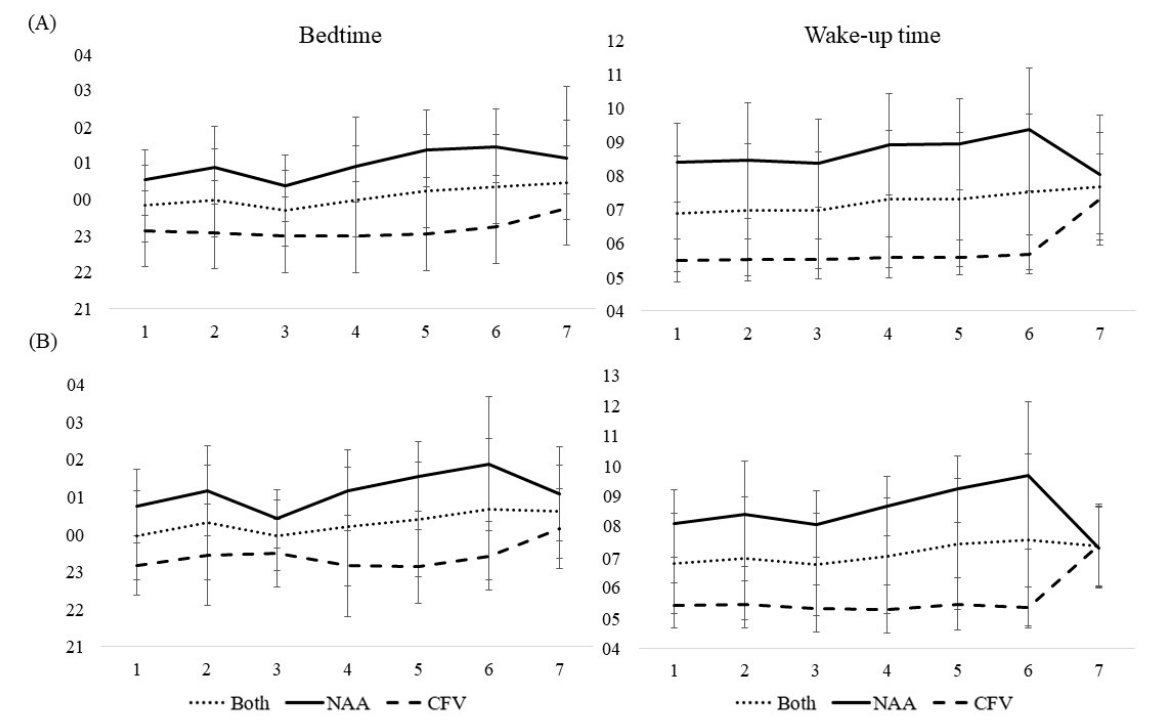
Figure 1. Mean scores of bedtime and wake-up time during a 7-day workweek among pilots in the Norwegian Air Ambulance (NAA; n = 25), Christophorus Flugrettungverein (CFV; n = 22), and both groups collapsed, measured by ( A ) sleep diary and ( B ) actigraphy. Error bars represent standard deviations.